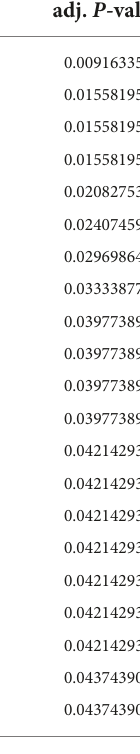
TABLE 1 Profiling subsets, which showed a significant difference in indicated protein expression level between pre- and post-RT, using the Astrolabe Platform. Cell